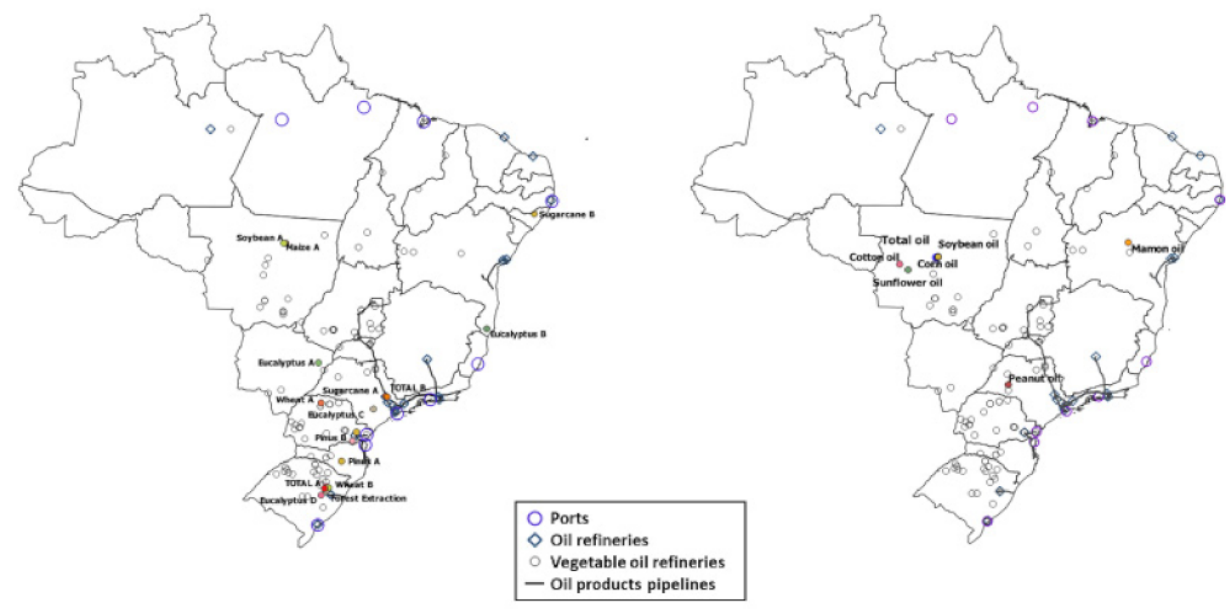
Figure 13. Hotspots and infrastructure in Brazil (biomass residues hotspots—left; SVO hotspots—right).